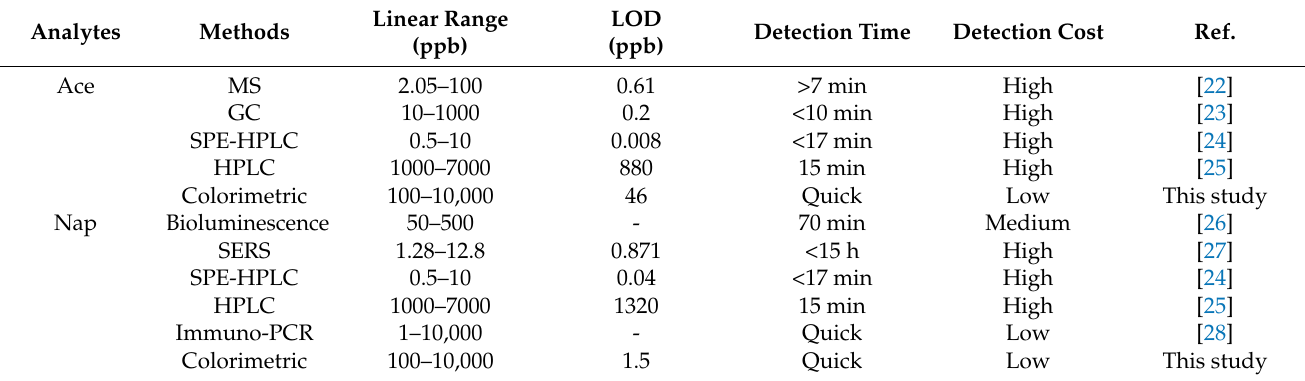
Table 1. Comparison of LOD for analytes with literature values.